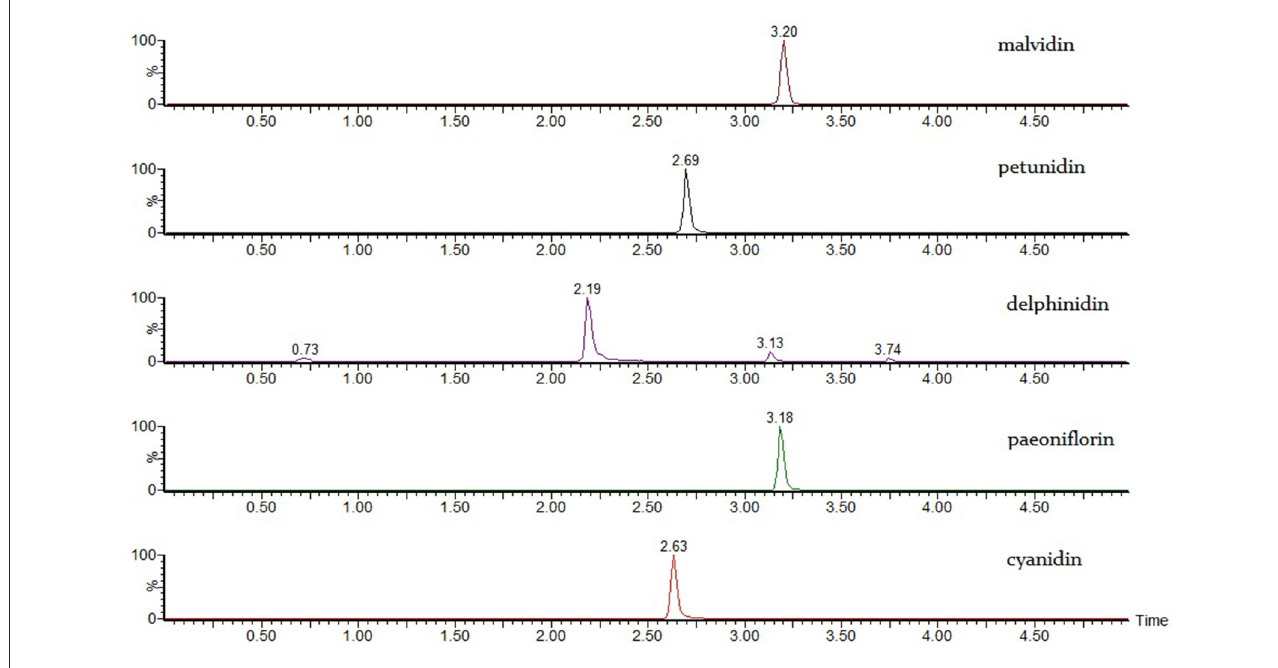
FIGURE6 Mass spectrogram of malvidin, petunidin, delphinidin, paeoniflorin, and cyanidin.